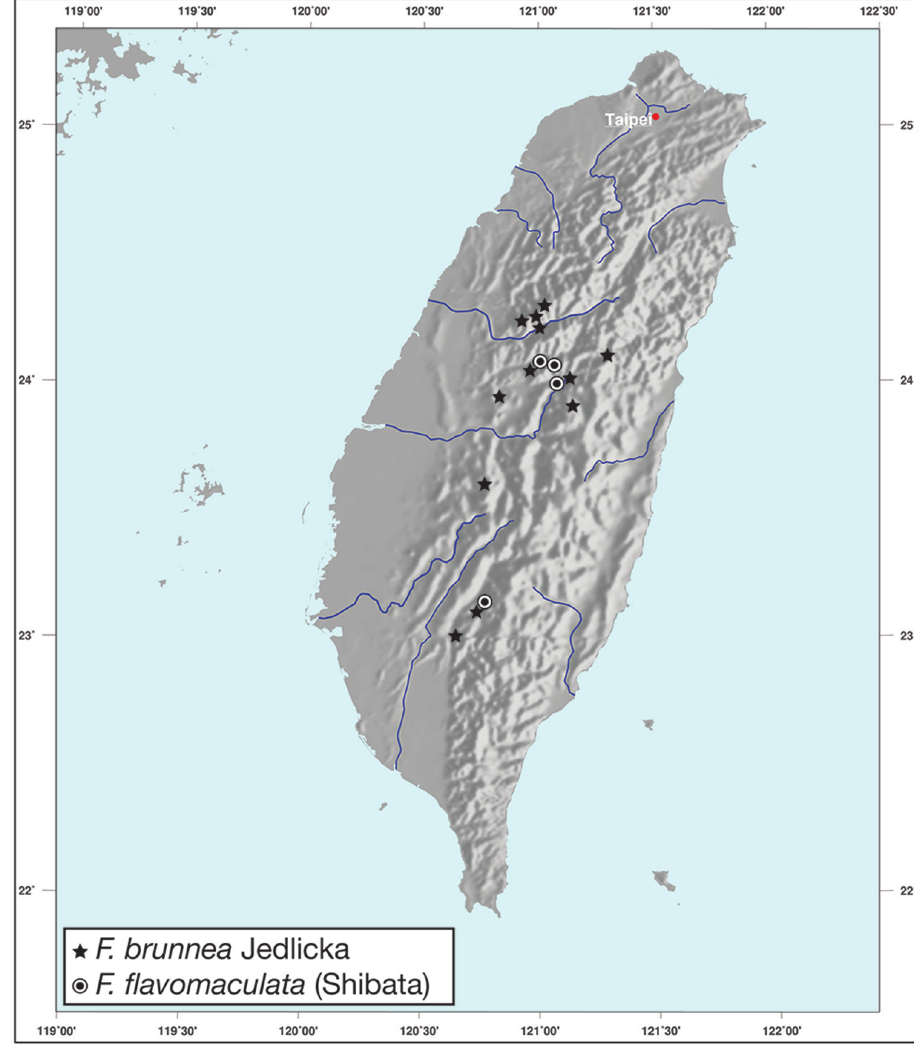
Figure 78. Map showing known localities for species of the genus Formosiella Jedlička, in